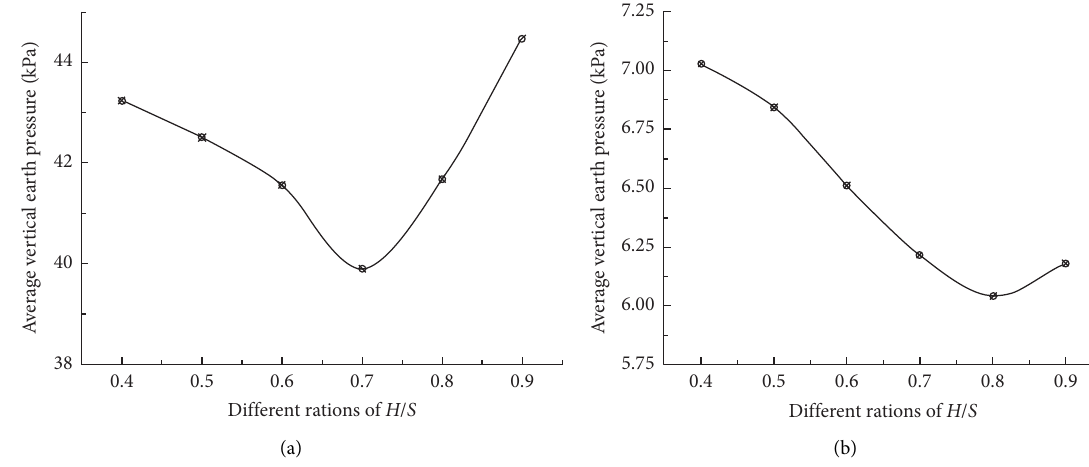
Figure 7: Average vertical earth pressure of different H/S ratios within a range of CCT top for cases (a) S1 and (b) S2.